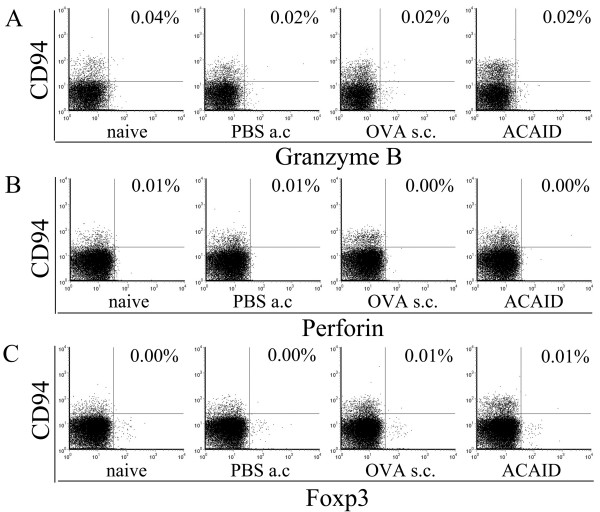
Expression of granzyme B, perforin and Foxp3 in CD8+CD94+T cells. Splenic MNC from ACAID mice, immunized mice, PBS-AC-injected mice and naïve mice were prepared and labeled with anti-CD3, anti-CD8, anti-CD94, anti-perforin, anti-granzyme B and anti-Foxp3 mAb. A: CD3+CD8+T population was gated and analyzed for the frequency of CD94+granzyme B+T cells. B: CD3+CD8+T population was gated and analyzed for the frequency of CD94+perforin+T cells. C: CD3+CD8+T population was gated and analyzed for the frequency of CD94+Foxp3+T cells. The results shown are representative of three independent experiments.